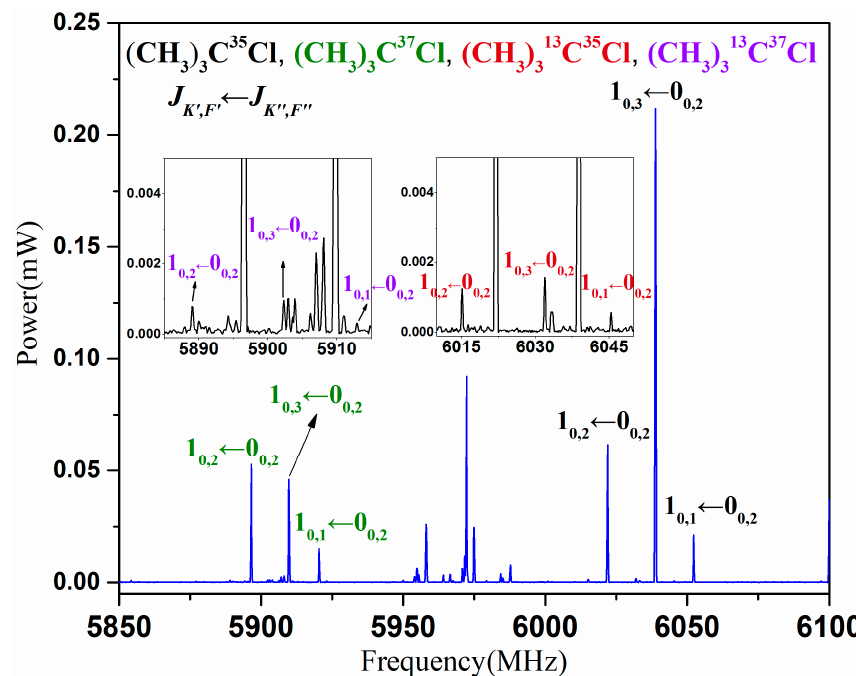
Figure 4. Diagram of measured hyperfine splitting of ground state ( J = 1 ← 0) energy level transitions ( J’ K’F’ ← J’’ K’’F’ ’ ) of (CH 3 ) 3 C 35 Cl, (CH 3 ) 3 C 37 Cl, (CH 3 ) 313 C 35 Cl, (CH 3 ) 313 C 37 Cl.